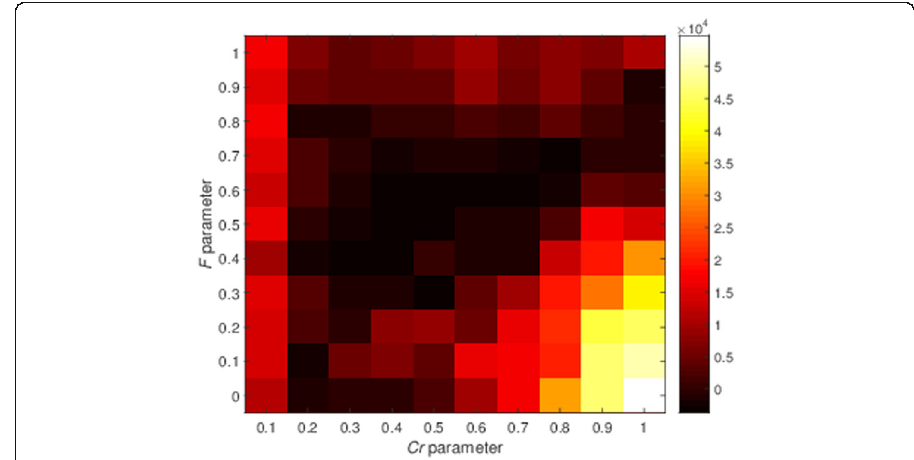
Fig. 4 Heatmaps of metaheuristic parameter tuning generated with Meta-ERM platform